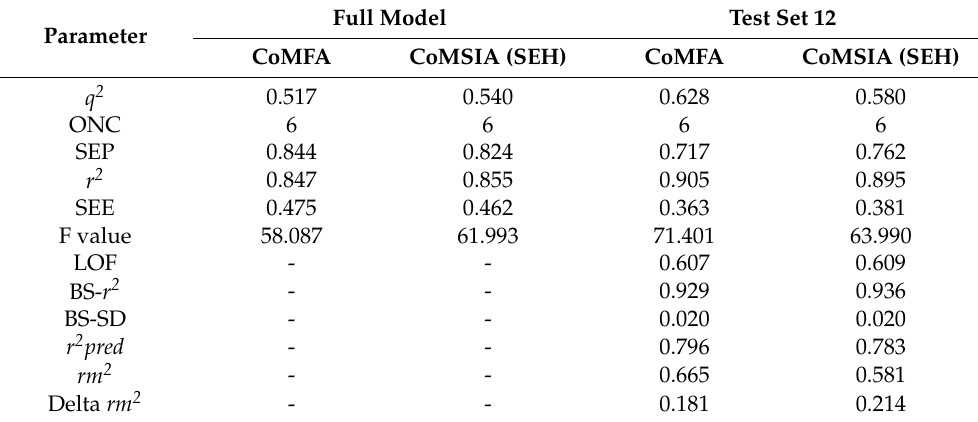
Table 1. Detailed statistical values of the selected CoMFA and CoMSIA models.